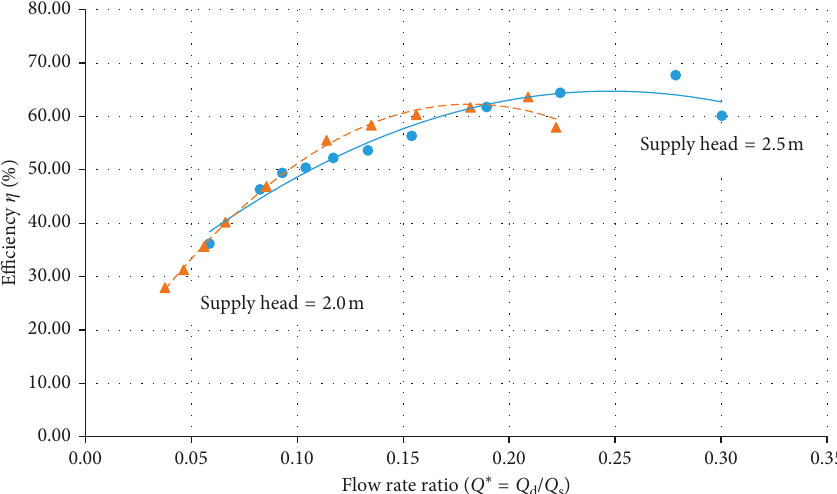
Figure 6: Efficiency vs. flow-rate ratio at difference head, h